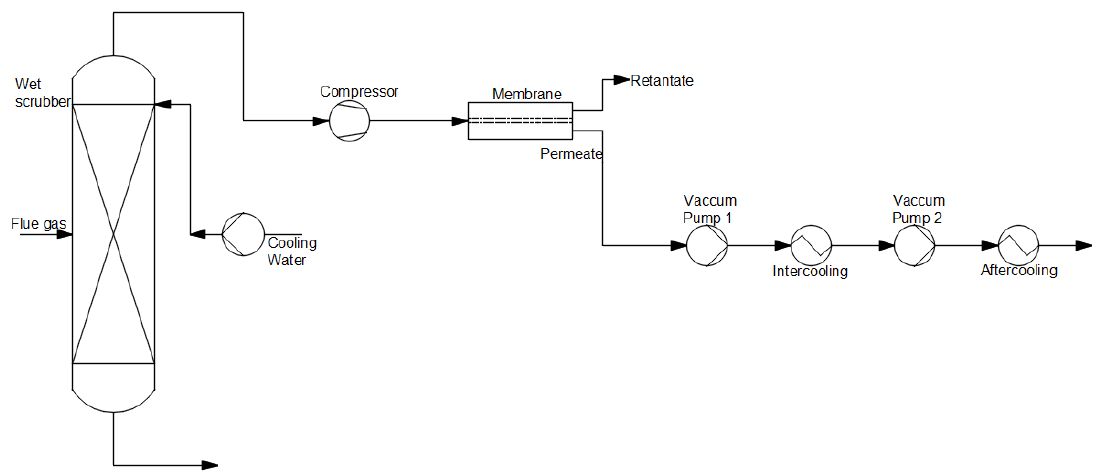
Figure 6. Scheme of the post-combustion CO 2 capture method using a membrane separation process (based on [22]).